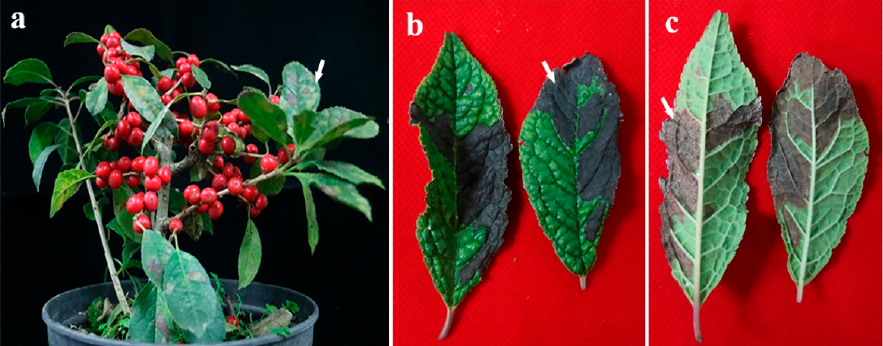
Figure 1. Symptoms of diseased winterberry holly. ( a ) Symptomatic leaves change from green to yellowish green, and gradually become grayish brown Coalesced irregular leaf spots eventually resulted in early plant defoliation. The arrow points to the spot. ( b , c ) A large area of irregular black–brown leaf spots with dense white mycelia on winterberry holly’s defoliation. The arrow points to white mycelia.